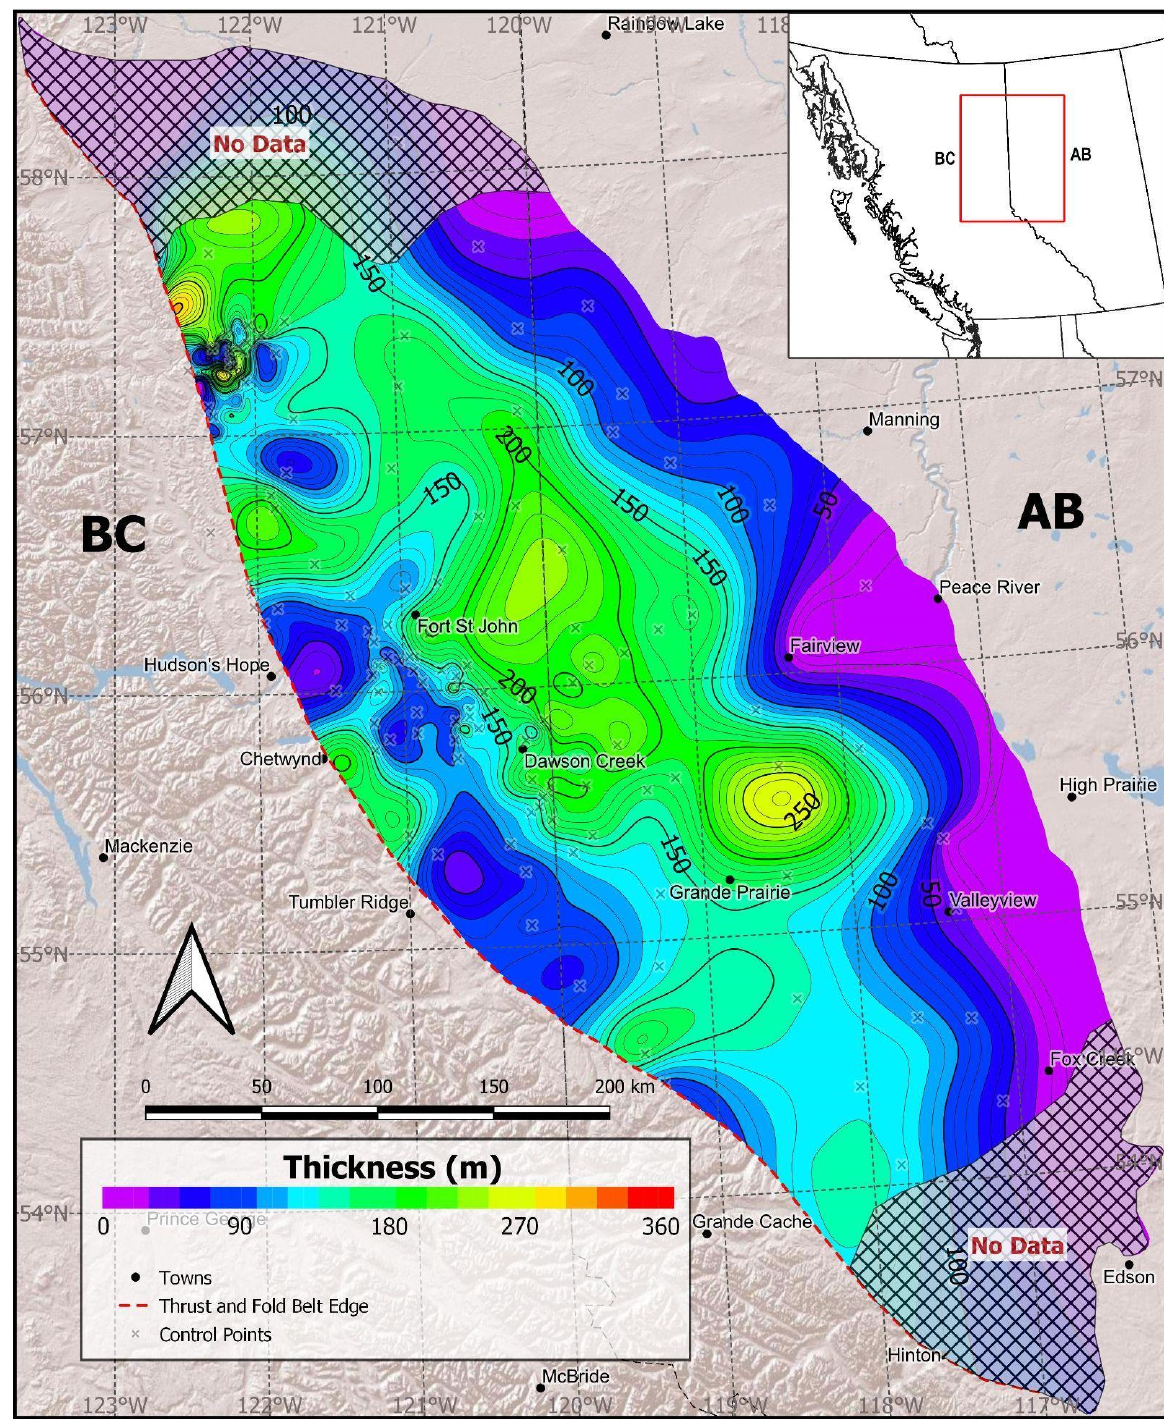
Figure 5. Thickness distribution of the Middle Montney Formation in British Columbia and Alberta. The Middle Montney Formation is a significant component of the total Montney Formation thickness.